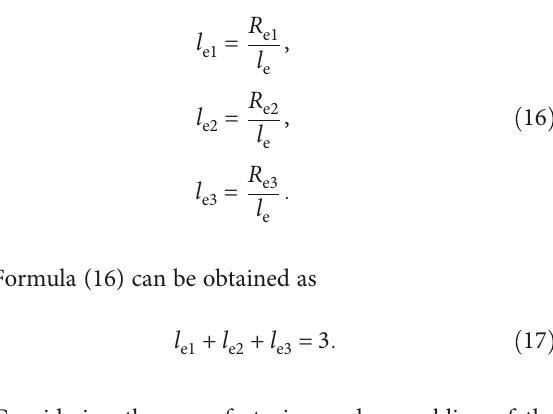
Figure 5: Globe kinematic decoupling performance evaluation index atlases of the elbow